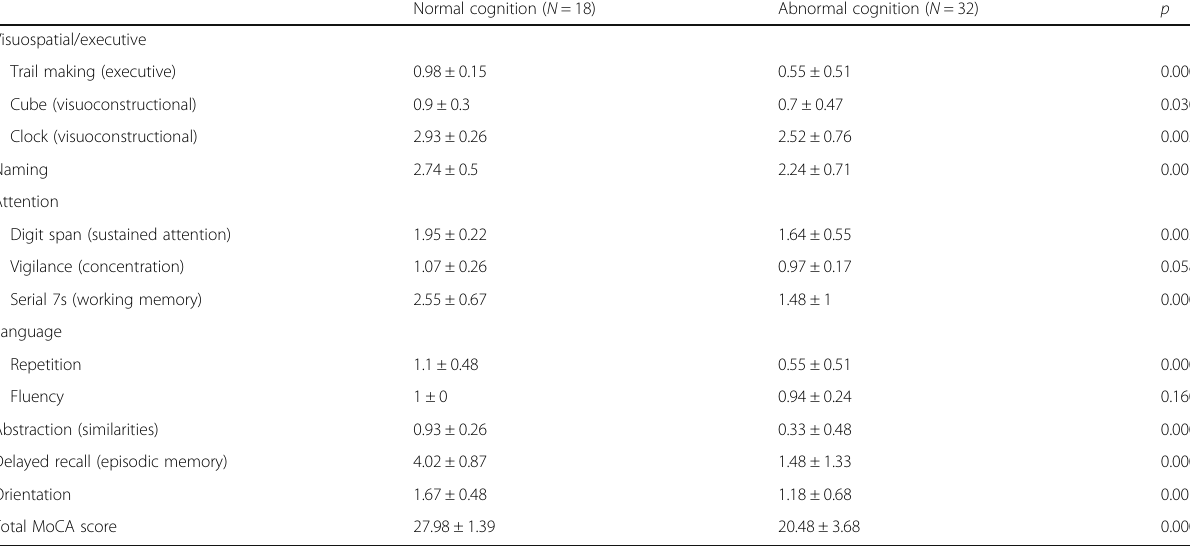
Table 4 Montreal cognitive assessment in MS with normal and abnormal cognition Normal cognition ( N